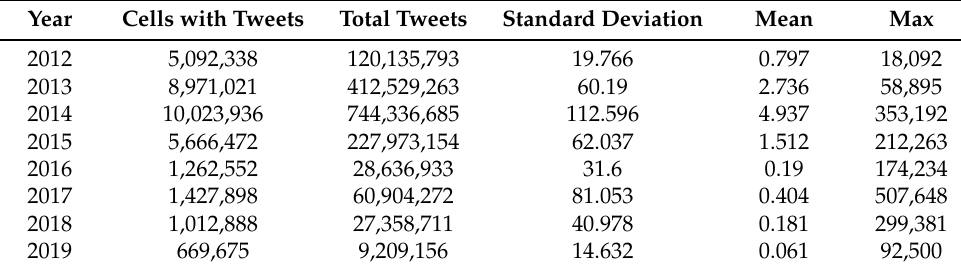
Table 1. Descriptive statistics of Twitter